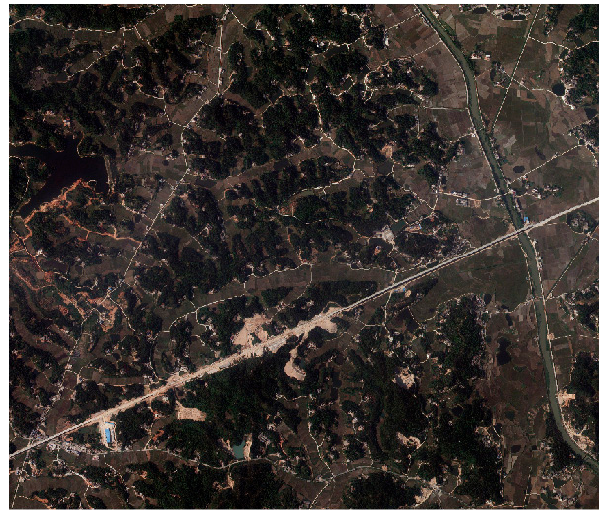
Figure 8. High-resolution aerial image of the study area.